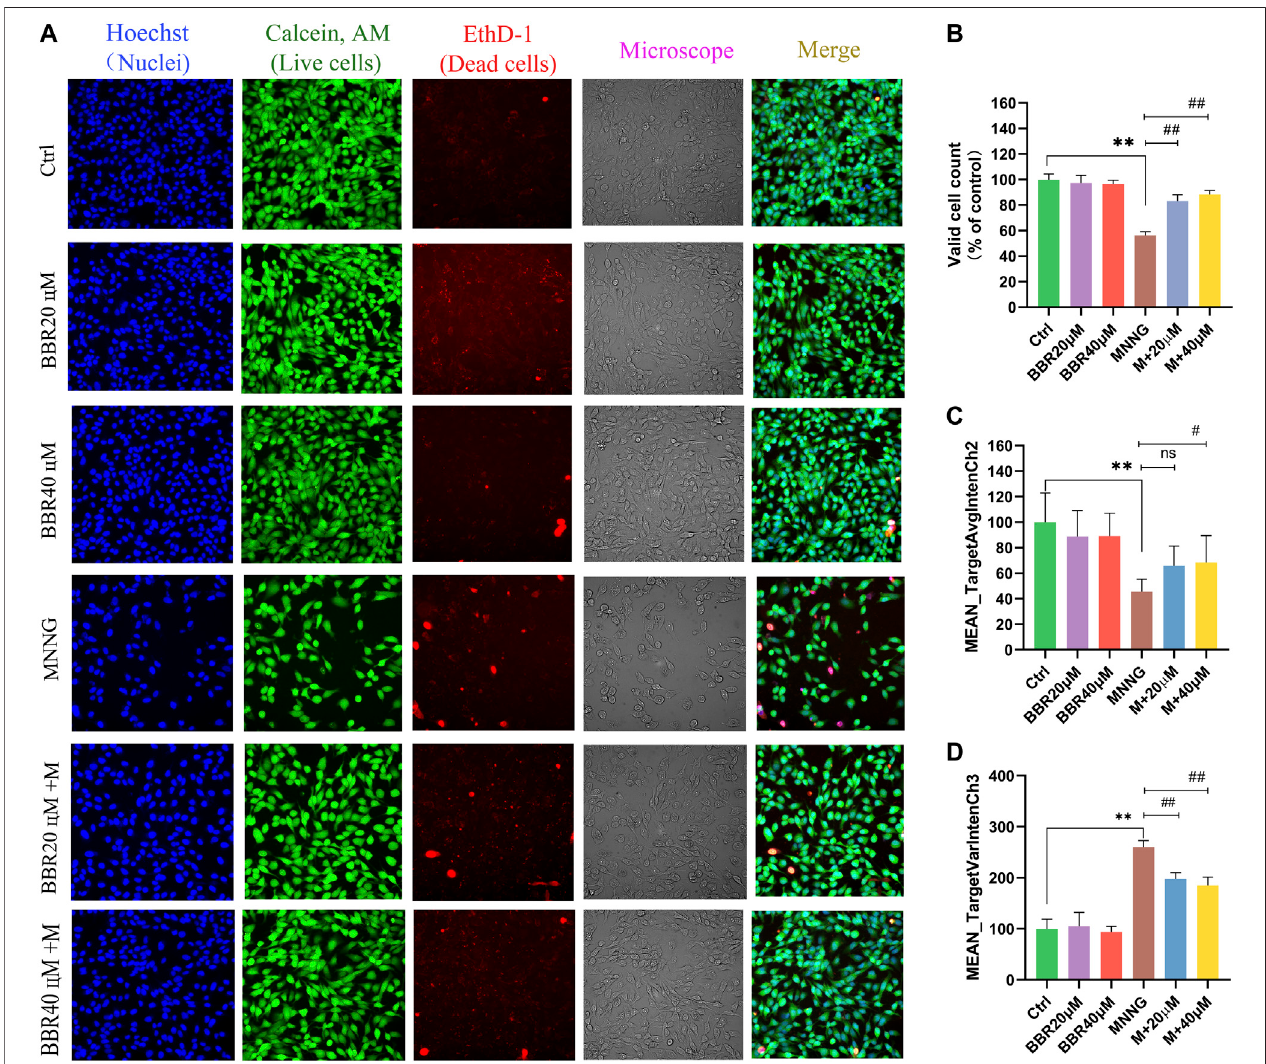
FIGURE 3 | Morphological identi fi cation and quantitative analysis of HCS imaging assay for GES-1 cells (A) Representative microphotographs of HCS image analysis ofGES-1 cells. Intensity of fl uorescence staining re fl ected the survival cells (green fl uorescence) and dead cells (red fl uorescence) (B) Valid cell counts ofGES-1 cells(%ofcontrol) (C) LivecellcountsofGES-1cells(MEAN_TargetAvgIntenCh2) (D) DeadcellcountsofGES-1cells(MEAN_TargetAvgIntenCh3).Datawereshownas mean ± SD. ** < 0.01 vs. control group. ## < 0.01 vs. MNNG group. Ns none-signi fi cant. Ctrl, Control; M, MNNG.